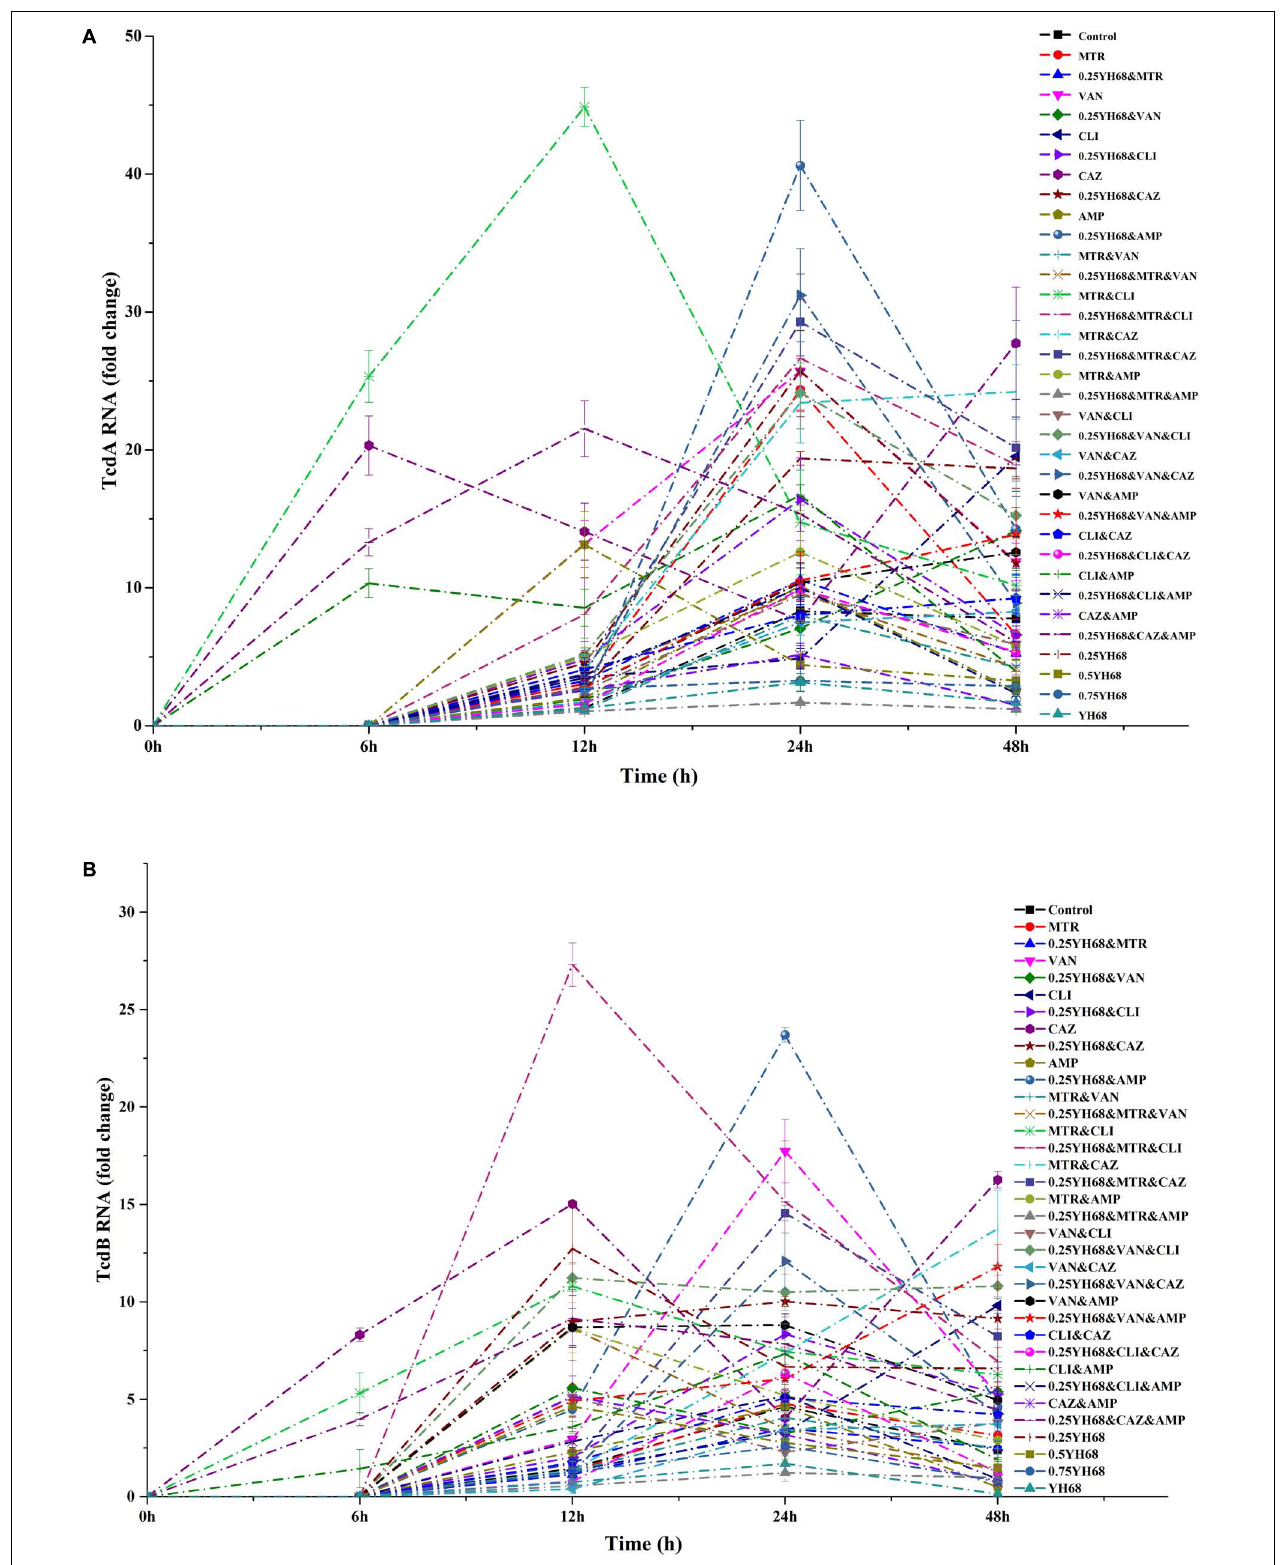
FIGURE 5 | Effects of different combinations on toxin gene expression in C. difficile ATCC 9689 ( A : tcdA, B : tcdB).